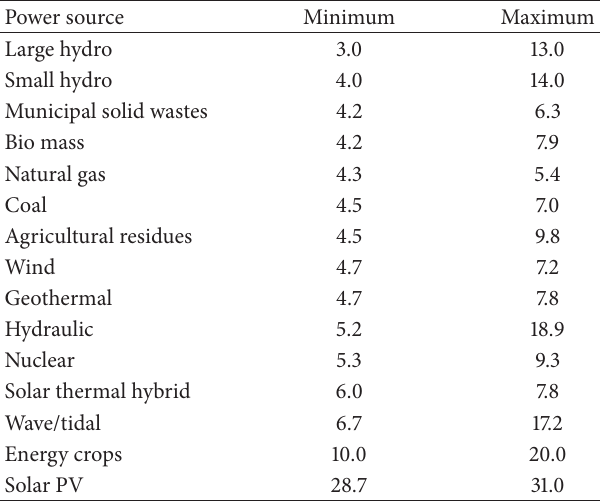
Table 4: Distribution of installed capacity according to Provinces of